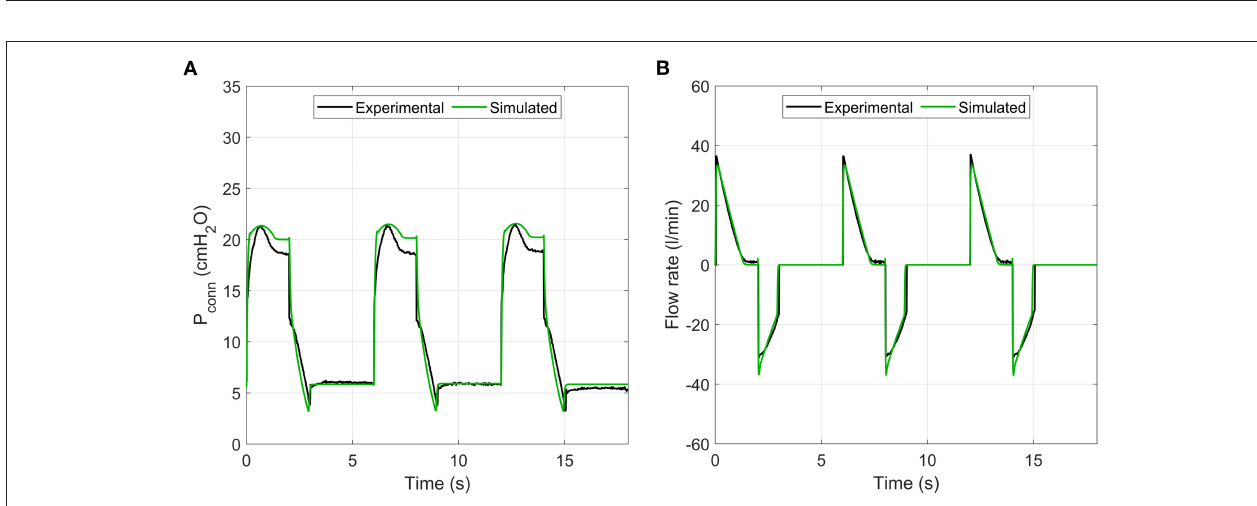
FIGURE 8 | 15 days of uninterrupted ventilation using the prototype system and R20/C25 test lung. Each data point represents 30s of averaged data every 10min. Grey bands represent the ISO 80601-2-12:2020 acceptable uncertainty in Tidal Volume, ± (4ml + 15% of the measured value), and the ISO 80601-2-12:2020 acceptable error in PEEP pressure measurements, ± 2 cmH 2 O.